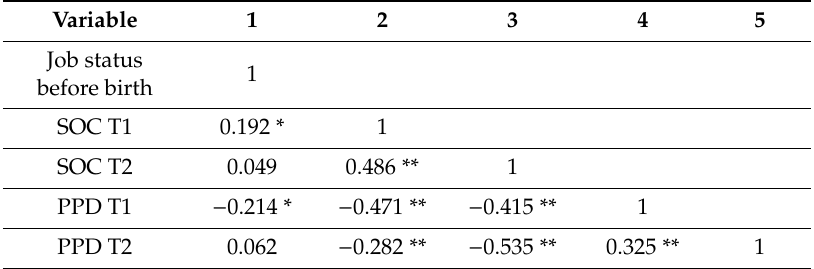
Table 4. Correlation matrix showing unstandardized values of the variables included in the final SEM model.